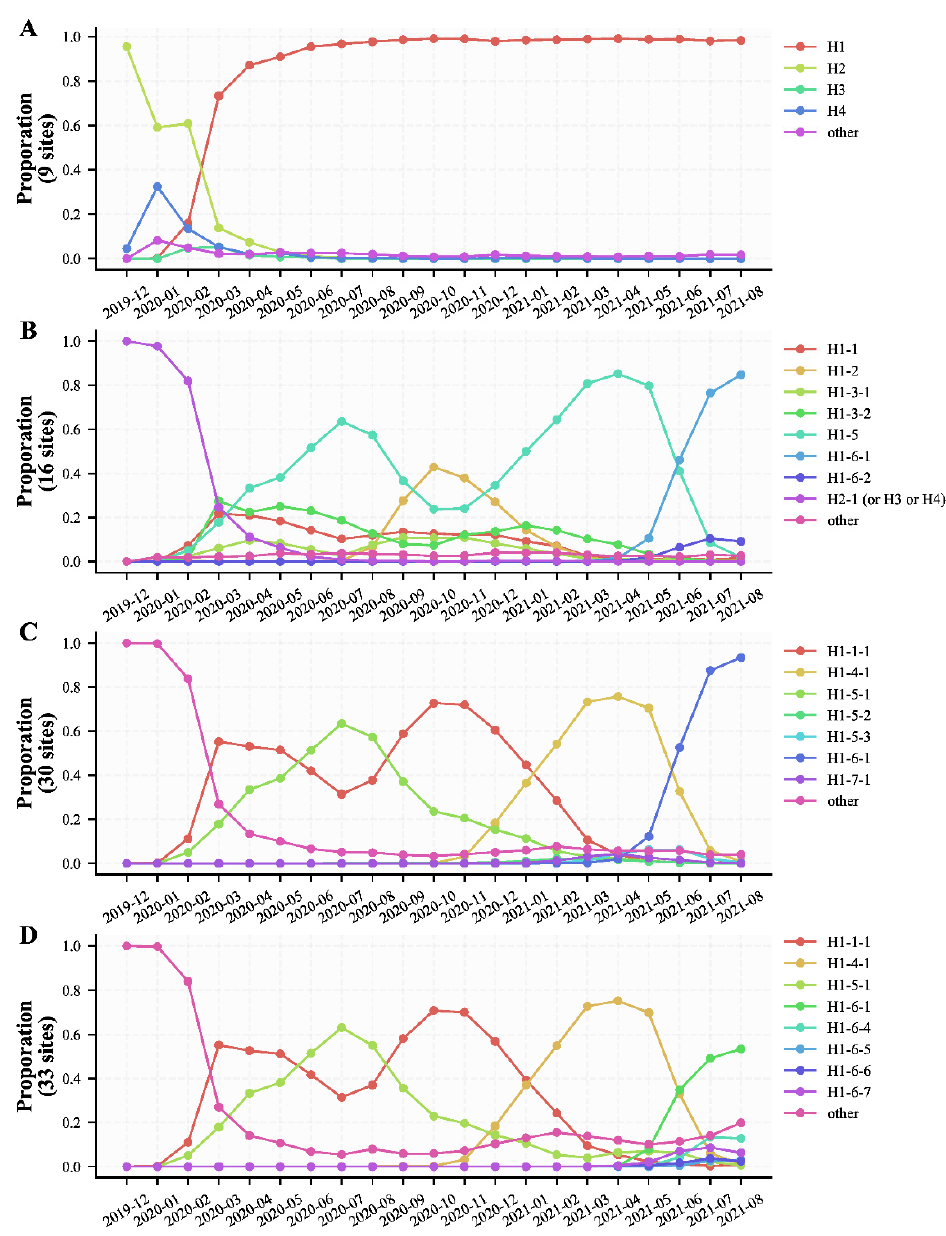
Figure 3. The changes of the proportion of different haplotype subtypes over time. ( A ) Proportion changes of the four haplotype subtypes defined by the nine specific mutation sites. ( B ) Proportion changes of the eight haplotype subtypes defined by the 16 specific mutation sites. ( C ) Proportion changes of the seven haplotype subtypes defined by the 30 specific mutation sites. ( D ) Proportion changes of the eight haplotype subtypes defined by the 33 specific mutation sites.